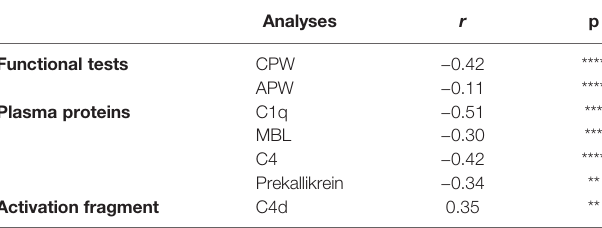
TABLE 4 | Correlations between C3 activation (C3d,g/C3) and parameters of the various complement pathways in COVID- 19 patients that provided serial samples (n =